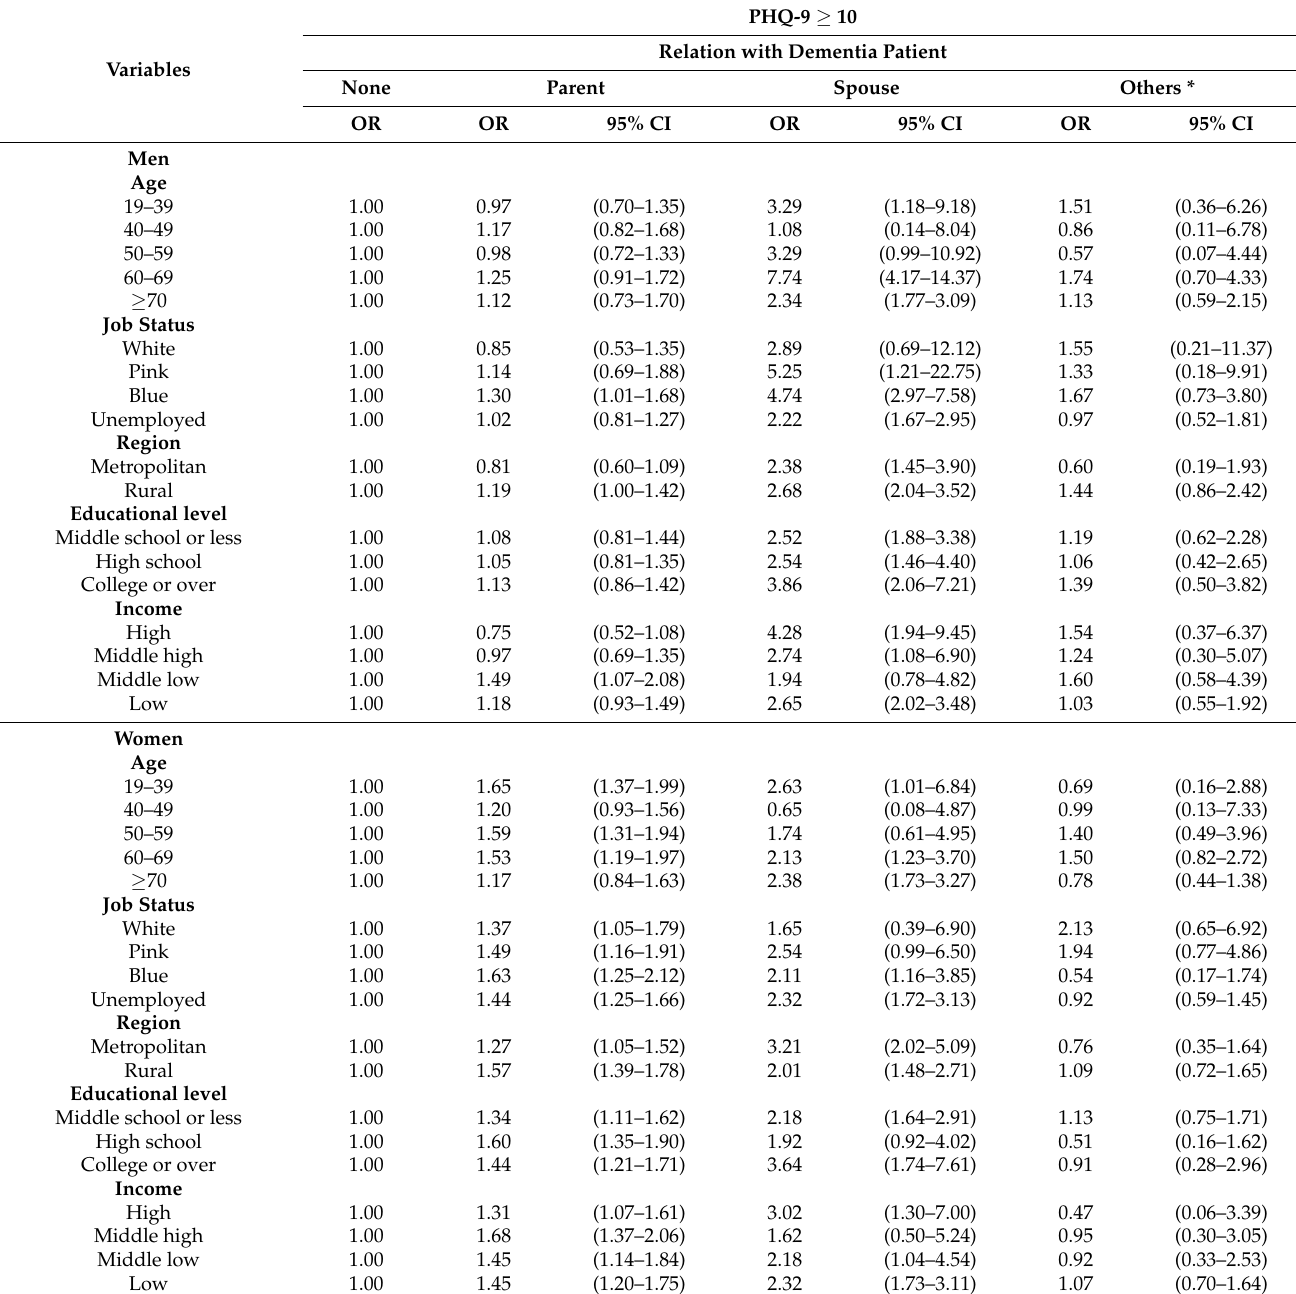
Table 3. Subgroup analysis of the association between relation with dementia patient and caregiver’ depressive symptoms stratified by sociodemographic